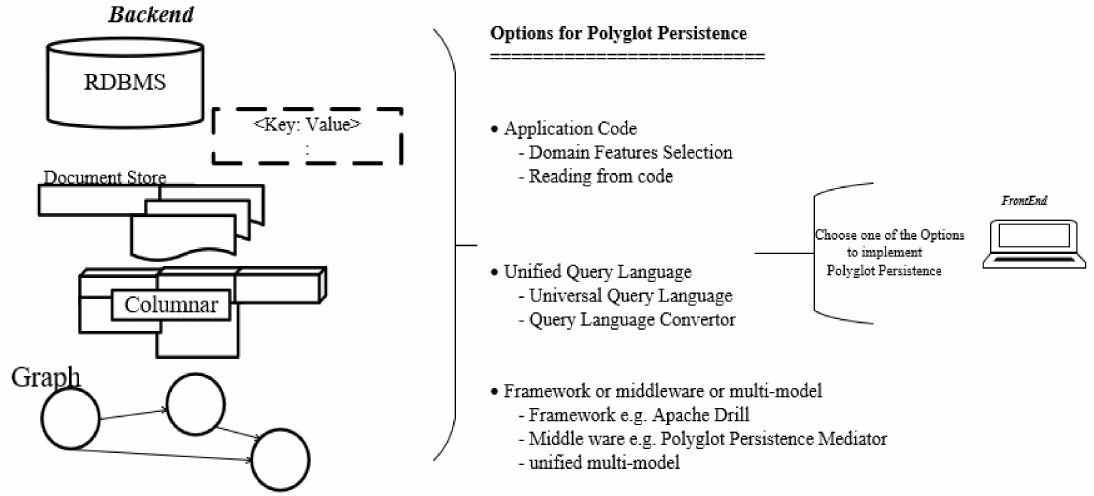
Figure 5. Approaches to implementing Polyglot